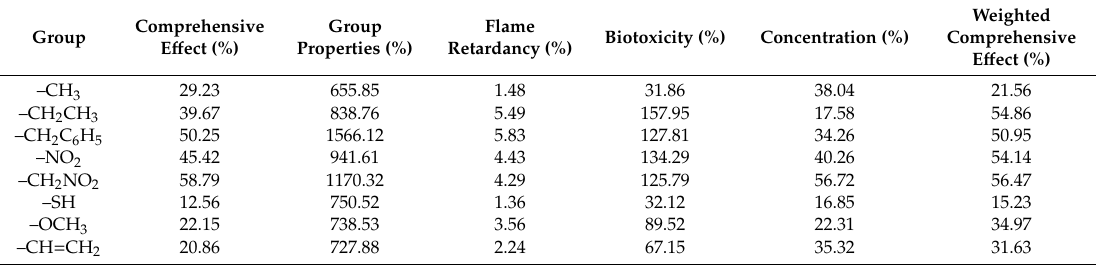
Table 10. Average improvement degree of comprehensive e ff ect and multiple single-e ff ect of 8 modified